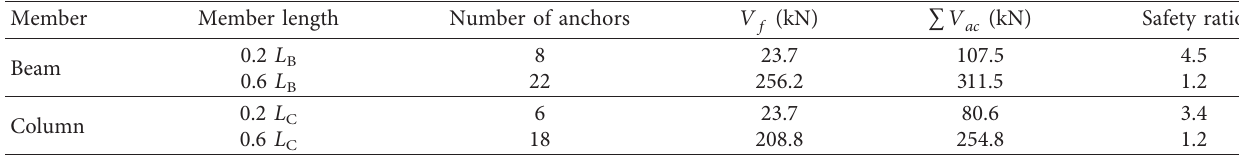
Figure 7: Ground motion accelerations used in the pseudodynamic test. (a) Time history records and (b) acceleration response spectrum. Table 4: ESRCF system joint connection test